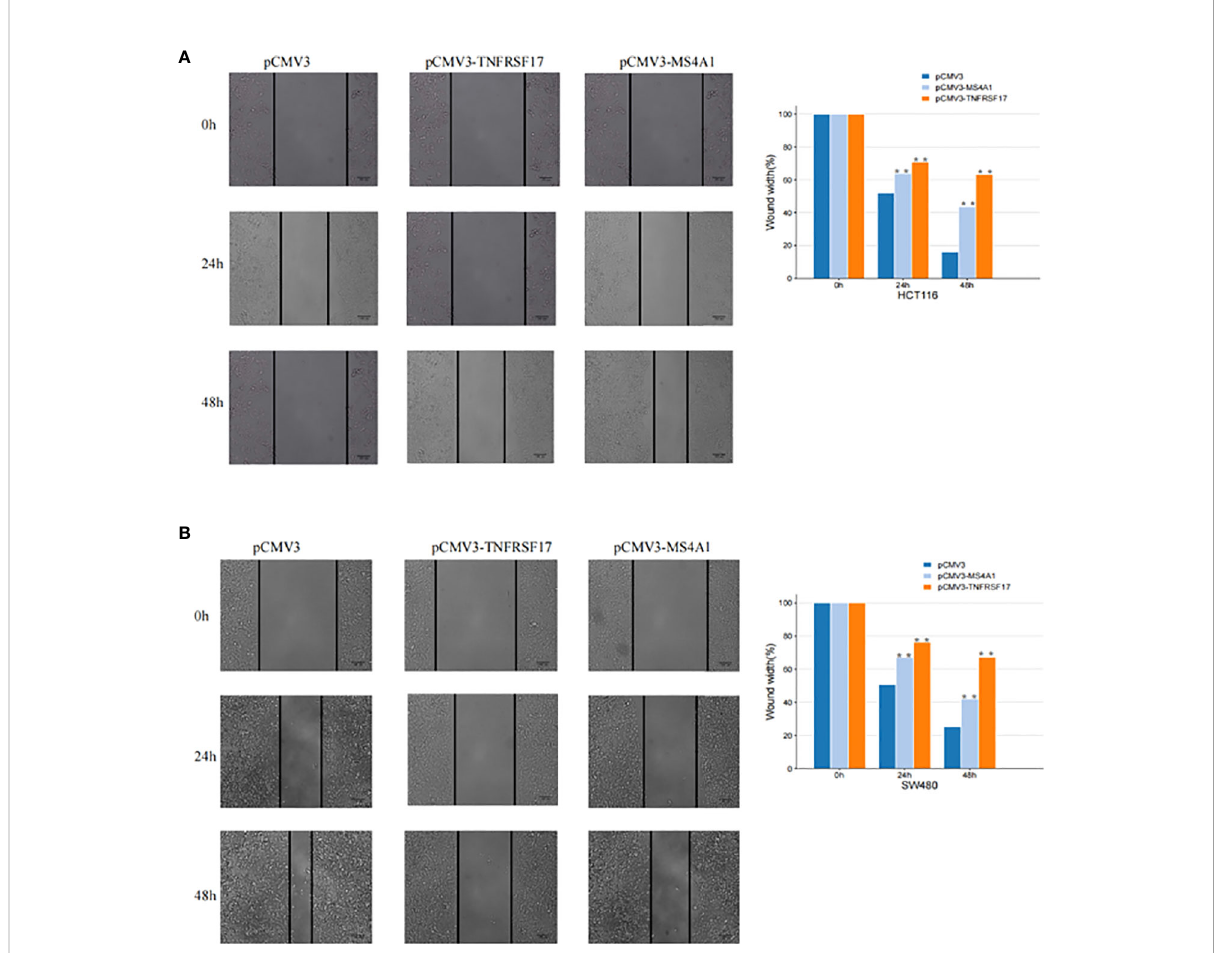
FIGURE 9 Cell scratch experiment. (A) The migration ability of SW480 cells transfected with pCMV3-MS4A1 and pCMV3-TNFRSF17 was signi fi cantly weakened. (B) The migration ability of HCT116 cells was signi fi cantly reduced after pCMV3-MS4A1 and pCMV3-TNFRSF17 were transfected.